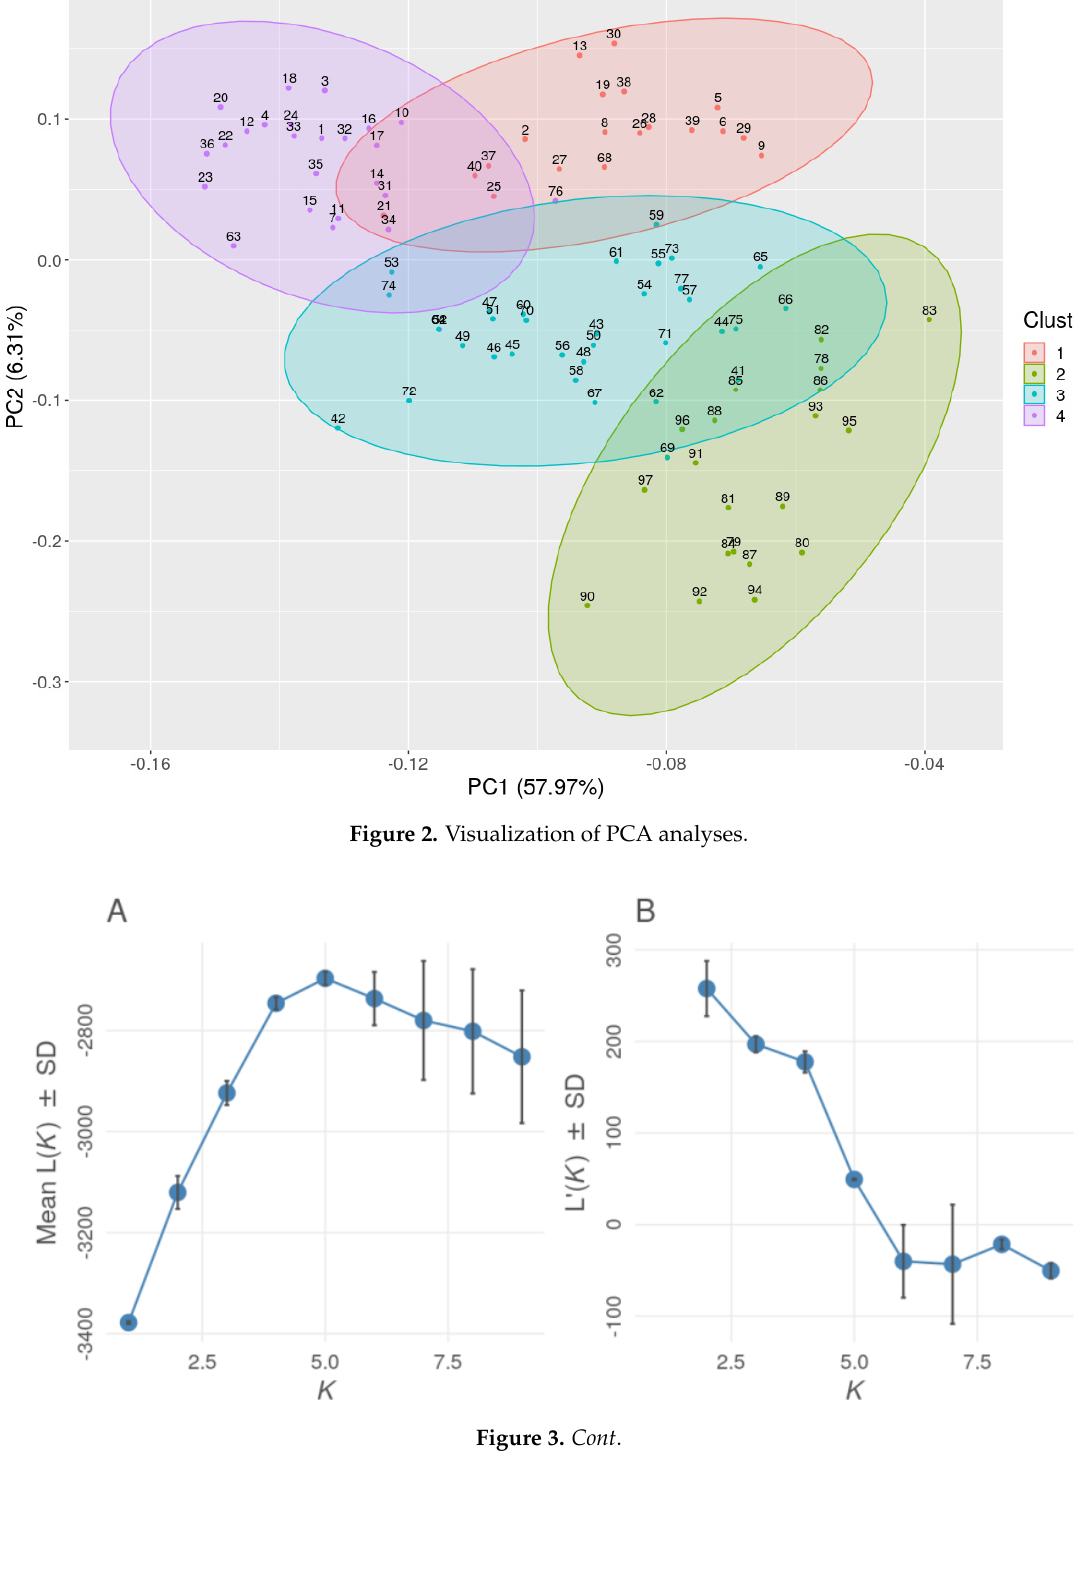
Figure 3. Presentation of the graphical method of identifying the true K value ( A ) Mean L (K) (± SD) of 15 runs for each K value. ( B ) Rate of change of the likelihood distribution calculated from the formula L ′ (K) = L (K)-L (K-1). ( C ) Second- order absolute values for the rate of change of the likelihood distribution, calculated from the formula | L ′ ′ (K) | = | L ′ (K + 1)-L ′ (K) |. ( D ) ∆ K calculated from the formula ∆ K = m | L ′ ′ (K) | / s [L (K)]. The absolute value of the peak of this distribution is the true K [17]. Two methods are distinguished in identifying the true K: (1) using a non-parametric test (Wilcoxon test); and (2) using the ∆ K algorithm. The first method is to detect K by analyzing the plot—when K approaches the true value, the mean of L (K) (± SD), the plot reaches a maximum and the values do not change or increase slightly, thus showing a high variance between the traces [18]. In the case of using the ∆ K algorithm, the true K value is determined by the peak values on the plot [17]. The conducted analyses of the ∆ K algorithm allowed us to indicate the optimal value of K = 4 (Figure 3, Supplementary Table S4). The admixture plots for mean values obtained from 45 independent runs for K = 3, K = 4, and K = 5 are presented in Figure 4 and Supplementary Table S5. For the optimal K = 4, the first group includes 16 genotypes, the second 21 genotypes, the third 33 genotypes, and the fourth 27 genotypes (Supplementary Table S5B). The largest group consists of the large-flowered varieties (12) and the medium- flowered varieties (23).The second cluster was dominated by small-flowered objects.